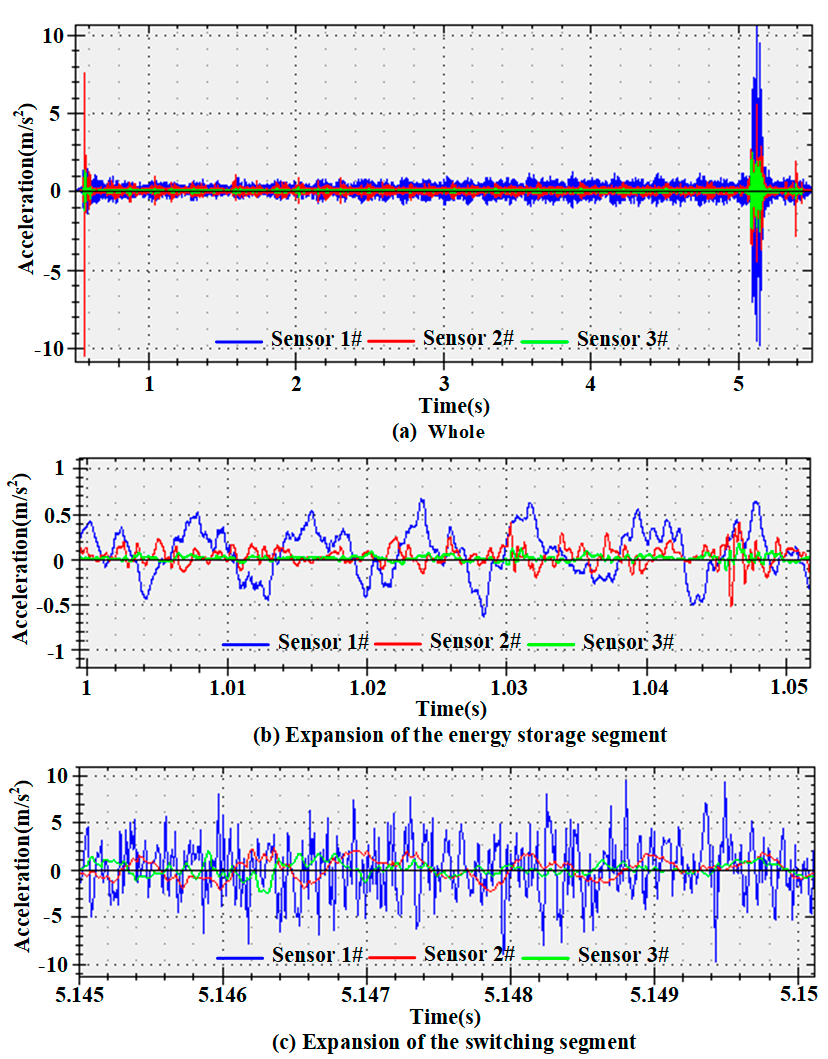
Figure 3. Waveforms of vibration signals at different measuring points.